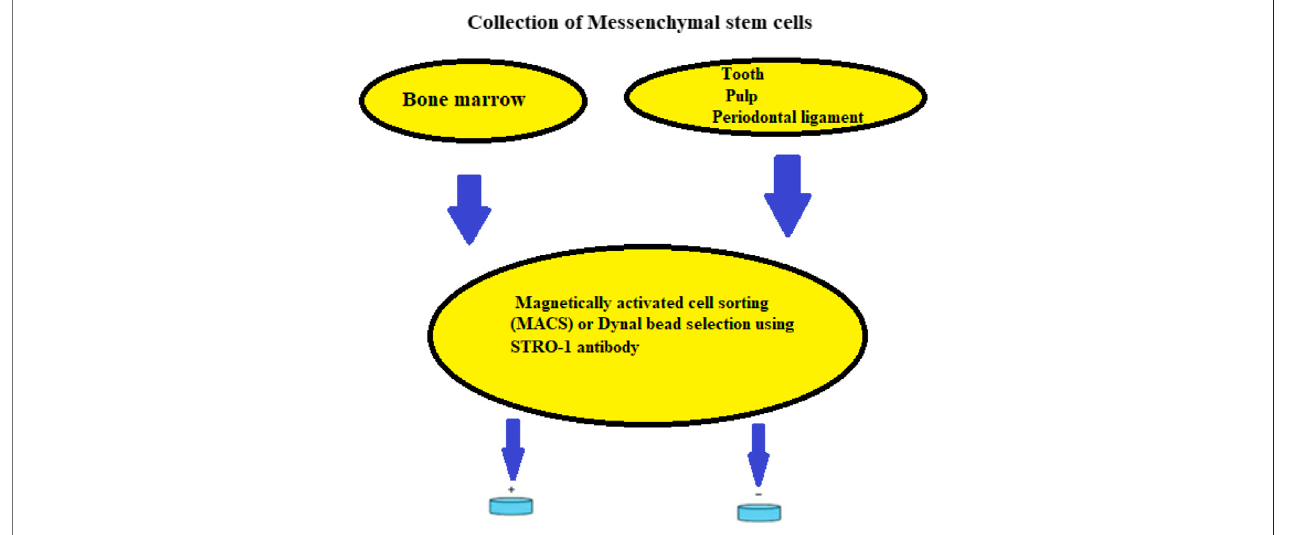
FIGURE 3 | Isolation of mesenchymal SCs from bone marrow, dental pulp, and periodontal ligament using a schematic representation.